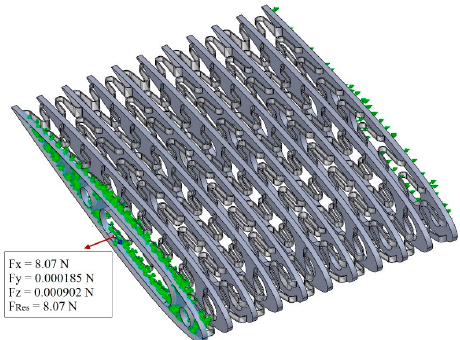
Figure 8. Fixed constraints, a 4 cm prescribed displacement in the longitudinal direction and the resultant reaction forces on the honeycomb substructure.